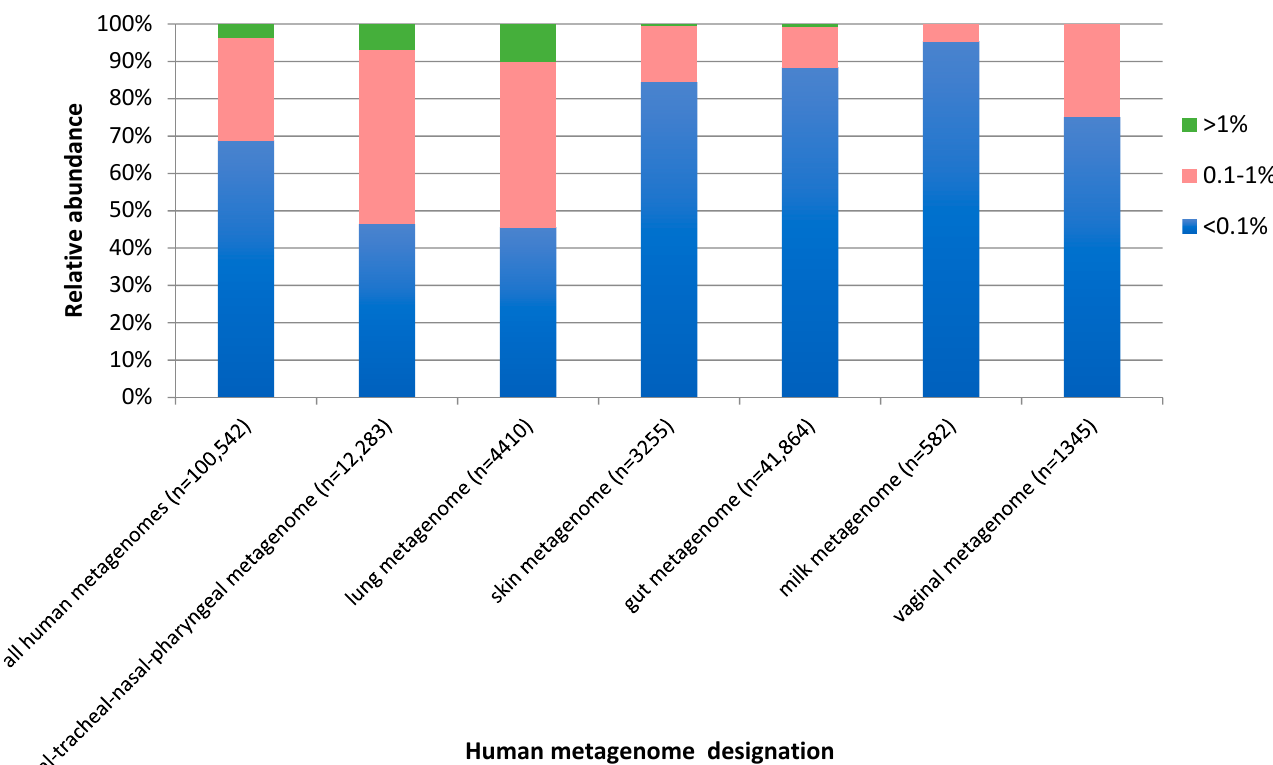
Figure 4. Relative abundance of S. moorei sequences in human metagenomes. The type of human metagenome is indicated on the left side of the figure, followed by, in brackets, the number of samples considered in the analysis for each type of metagenome. SRA: sequence read archive.